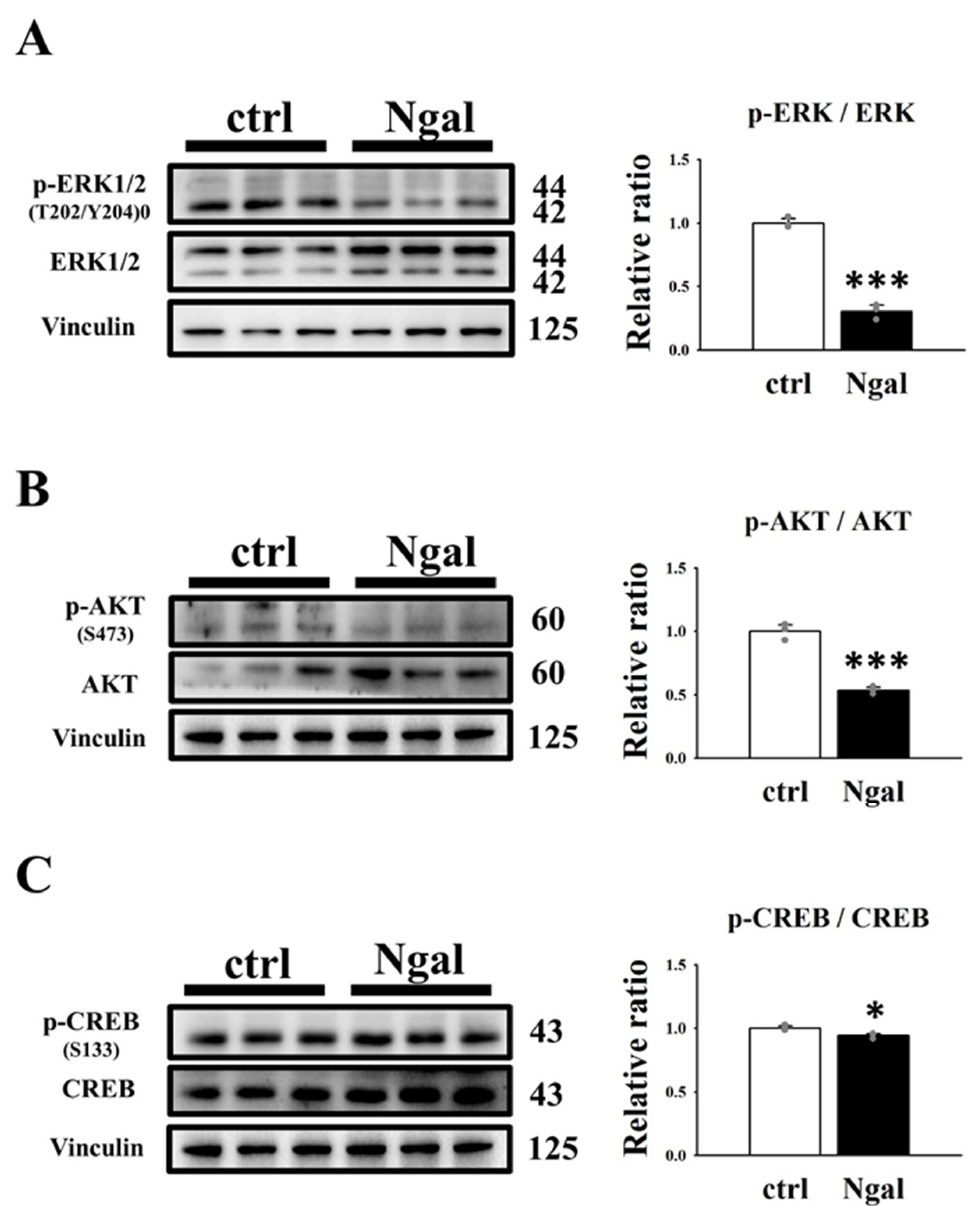
Figure 4. Effects of mNGAL on proliferation-related signaling pathways in 2L3 cells. Western blot results showed that mNGAL treatment for 24 h decreased the ratio of p-ERK/ERK ( A ) p-AKT/AKT ( B ) and p-CREB/CREB ( C ) in 2L3 cells. Vinculin was used as the internal control of each sample. Values were normalized to the control group. Student’s t -test was performed to determine the significance between groups ( n = 3). * p < 0.05; *** p < 0.001 vs. control group.